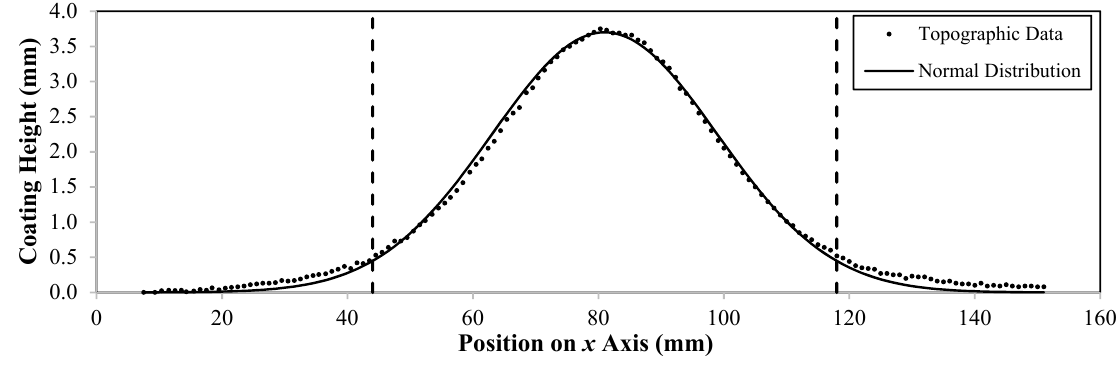
Figure 2. Spray pattern photos and raw surface topography data illustrating variation in spray pattern flatness and area observed in this study.